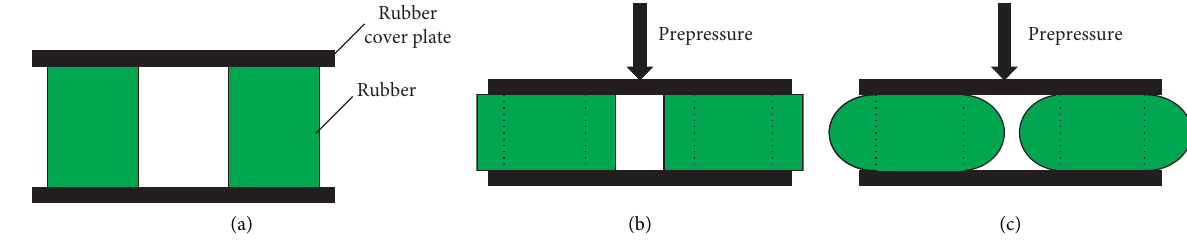
Figure 1: Diagram of circular rubber pad when compressed.